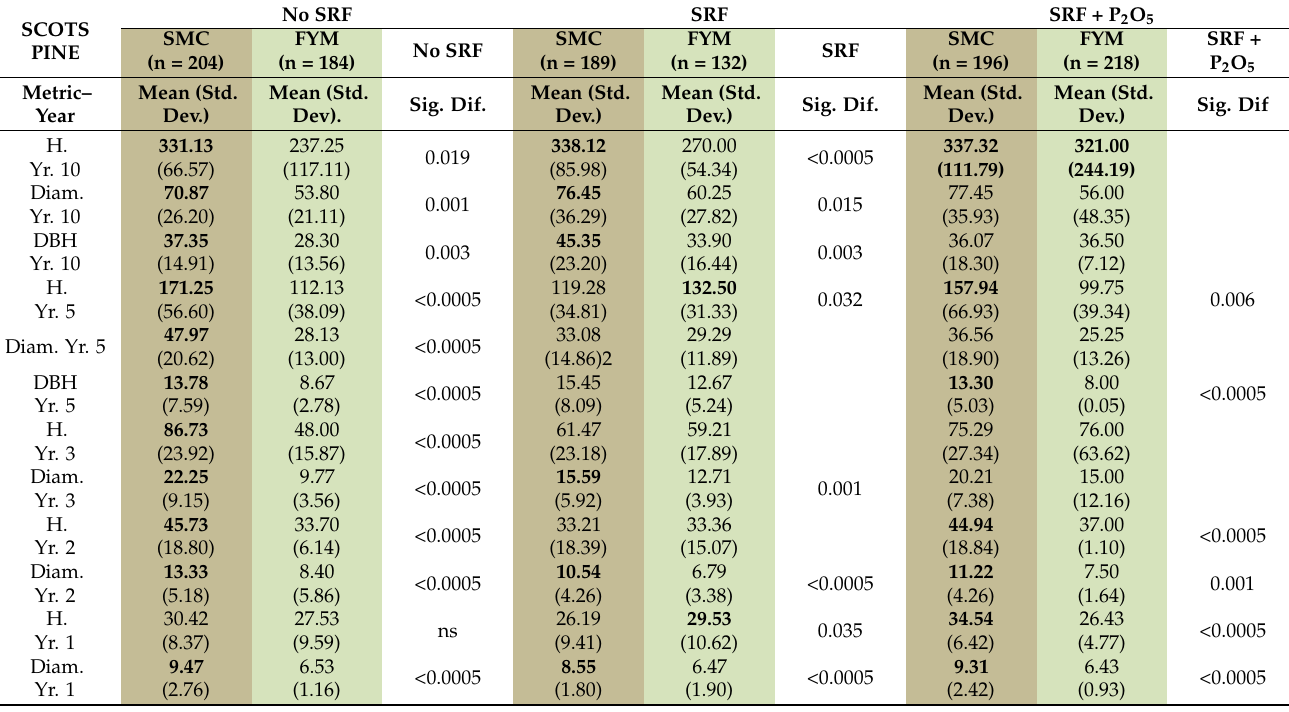
Table 12. Comparison of Scots Pine with SMC- or FYM-planting compost and fertilizer. (Nb: height (H) cm; DBH: mm, Diam. (diameter above root collar): mm; ratio FYM/SMC; ns: differences not significant).